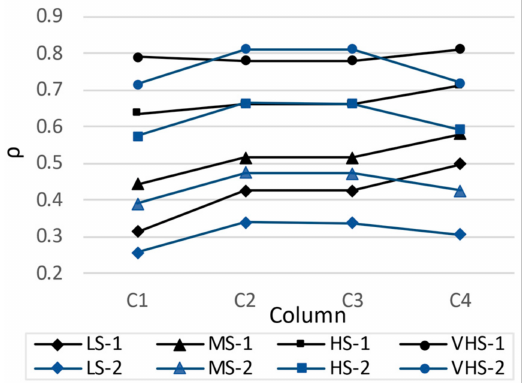
Figure 17. Strut indexes of the examined